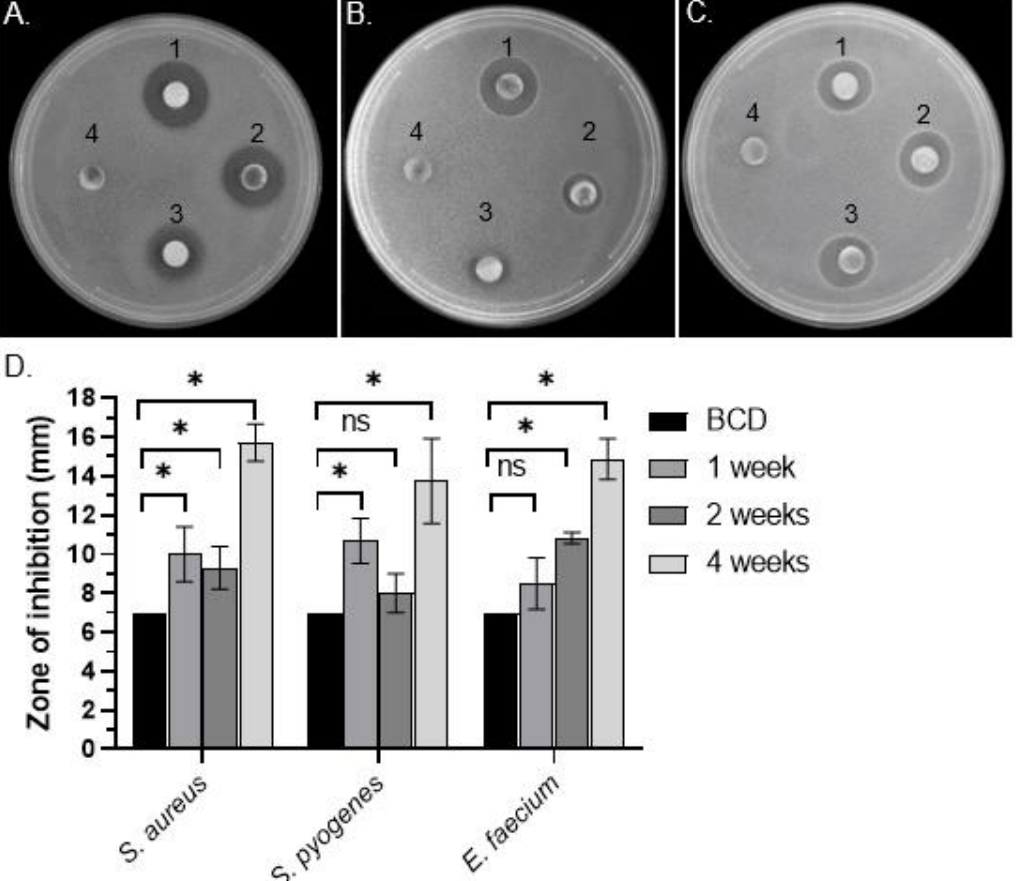
Figure 1. Bacterial growth inhibitory activity of extracellular metabolites of C. purpureus strains. ( A – C ) Representative pictures of qualitative DDM assays with filter disks soaked with exudates from four-week-old C. purpureus R40 strain and placed on top of S. aureus ATCC25923 ( A ), S. pyogenes ATCC12344 ( B ), and E. faecium ATCC35667 ( C ) bacterial lawns. (1–3) Disk with C. purpureus exudates; (4) negative control disks containing only BCD medium. ( D ) Diameter of S. aureus growth inhibition area (halo) around each cellulose disk containing secreted C. purpureus metabolites after one, two, and four weeks of moss growth was measured and plotted. Data represent the means from at least 3 independent experiments and a standard deviation. The asterisks indicate significance in an unpaired t-test; * — statistical significance p ≤ 0.05; ns— not significant.